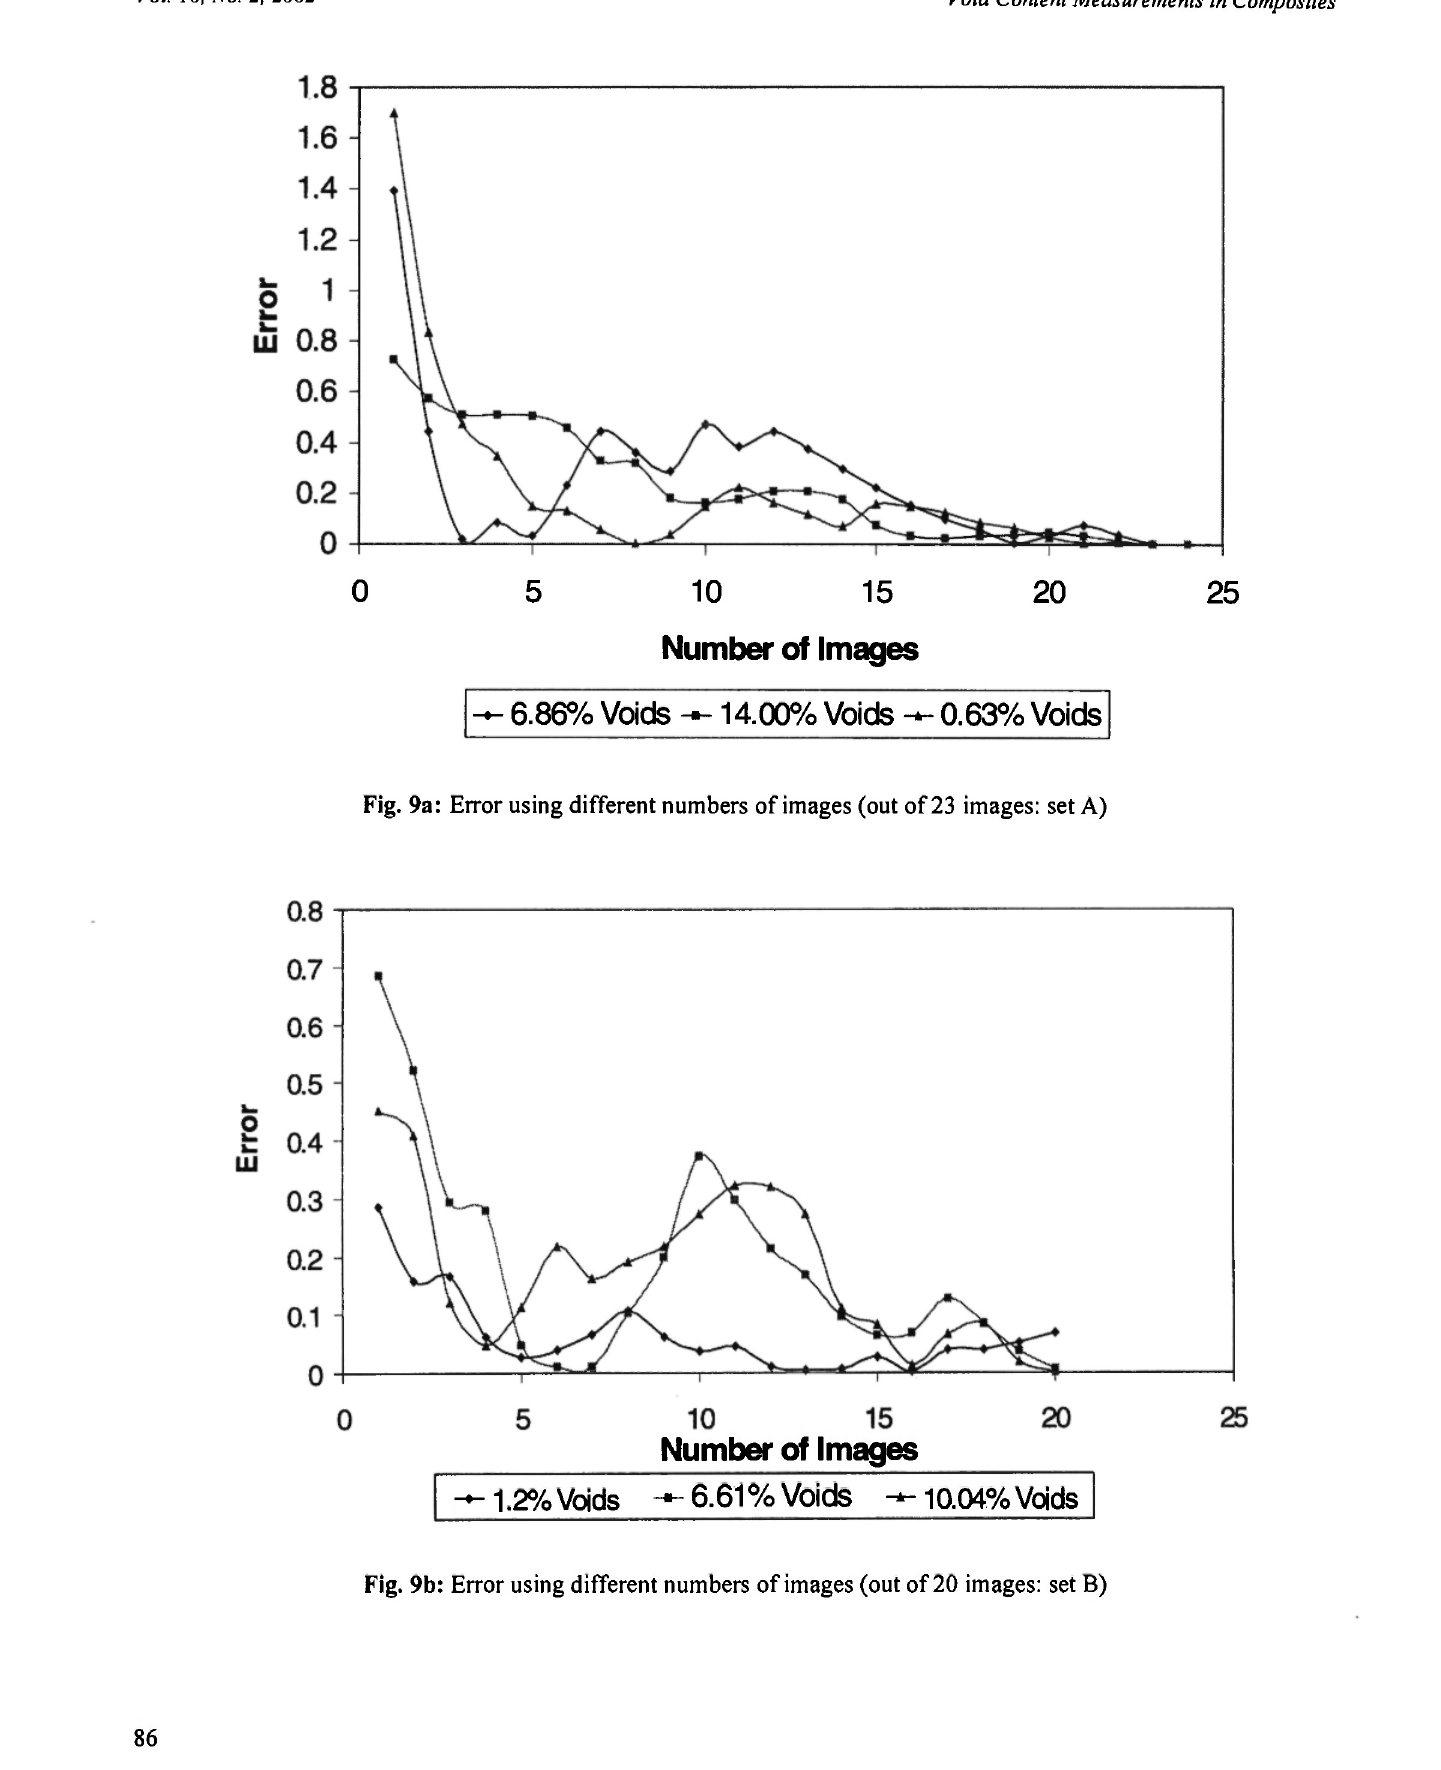
Fig. 9a: Error using different numbers of images (out of 23 images: set A)